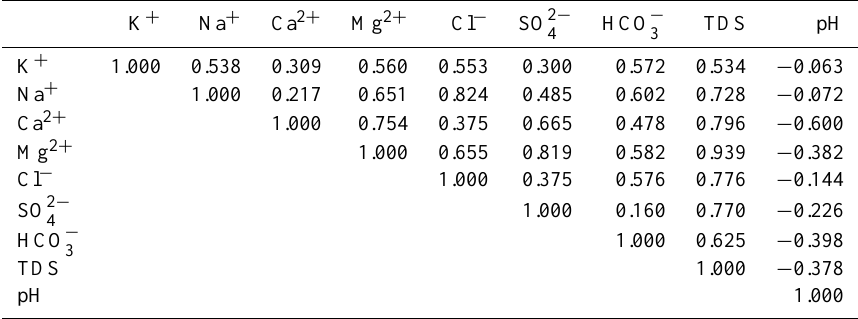
Table 2. Correlation coefficient of major parameters in groundwater.